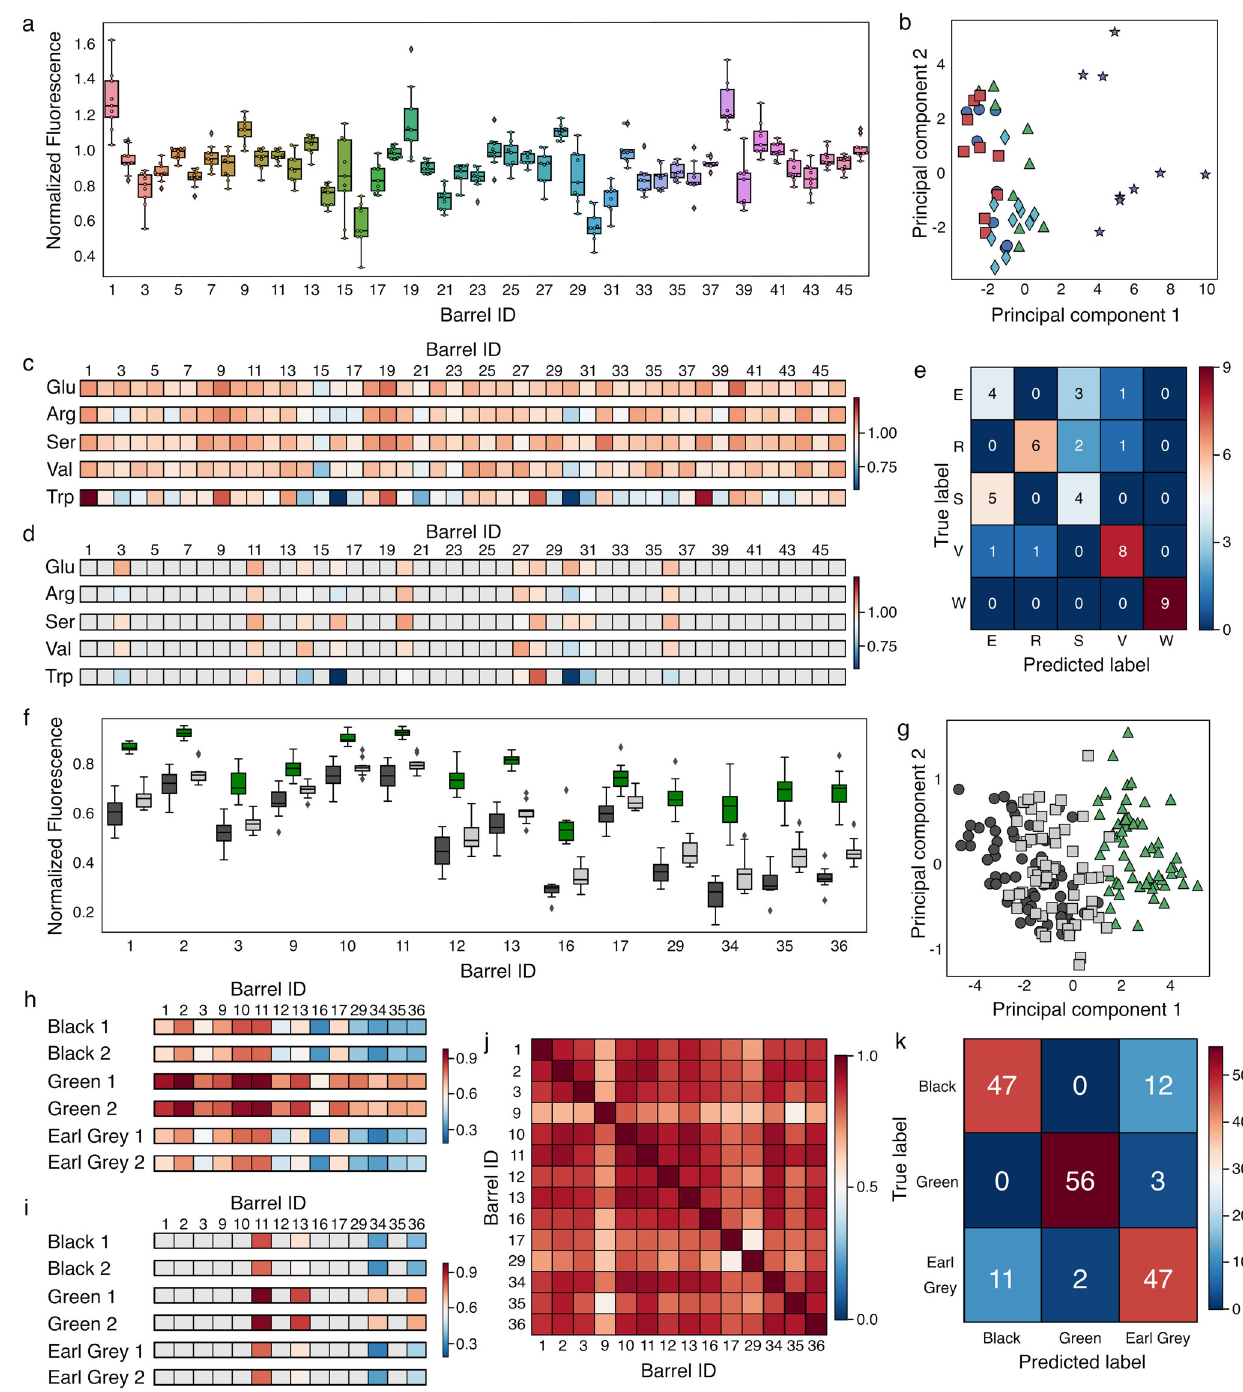
(Figs. 2 and 3, Supplementary Data File 1), which consisted of peptides that had been characterized previously 27 – 29 . We tested three classes of tea — black tea, Earl Grey, and green tea — and chose 10 brands for each (Supplementary Table 6). We collected 6 replicates for each brand, resulting in 178 tea fi ngerprints after outlier removal to train the ML